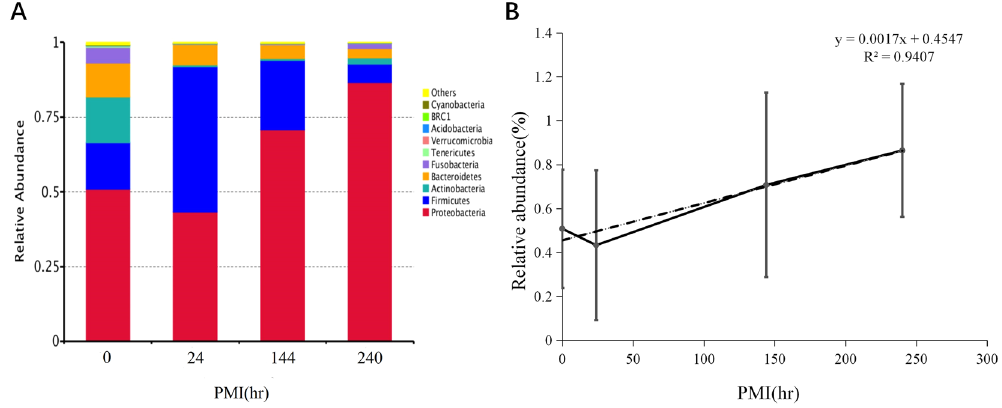
Figure 1. ( A ) Relative abundance of phyla of bacteria with different PMI. ( B ) Relative abundance changes of Proteobacteria had high positive linear relationship with